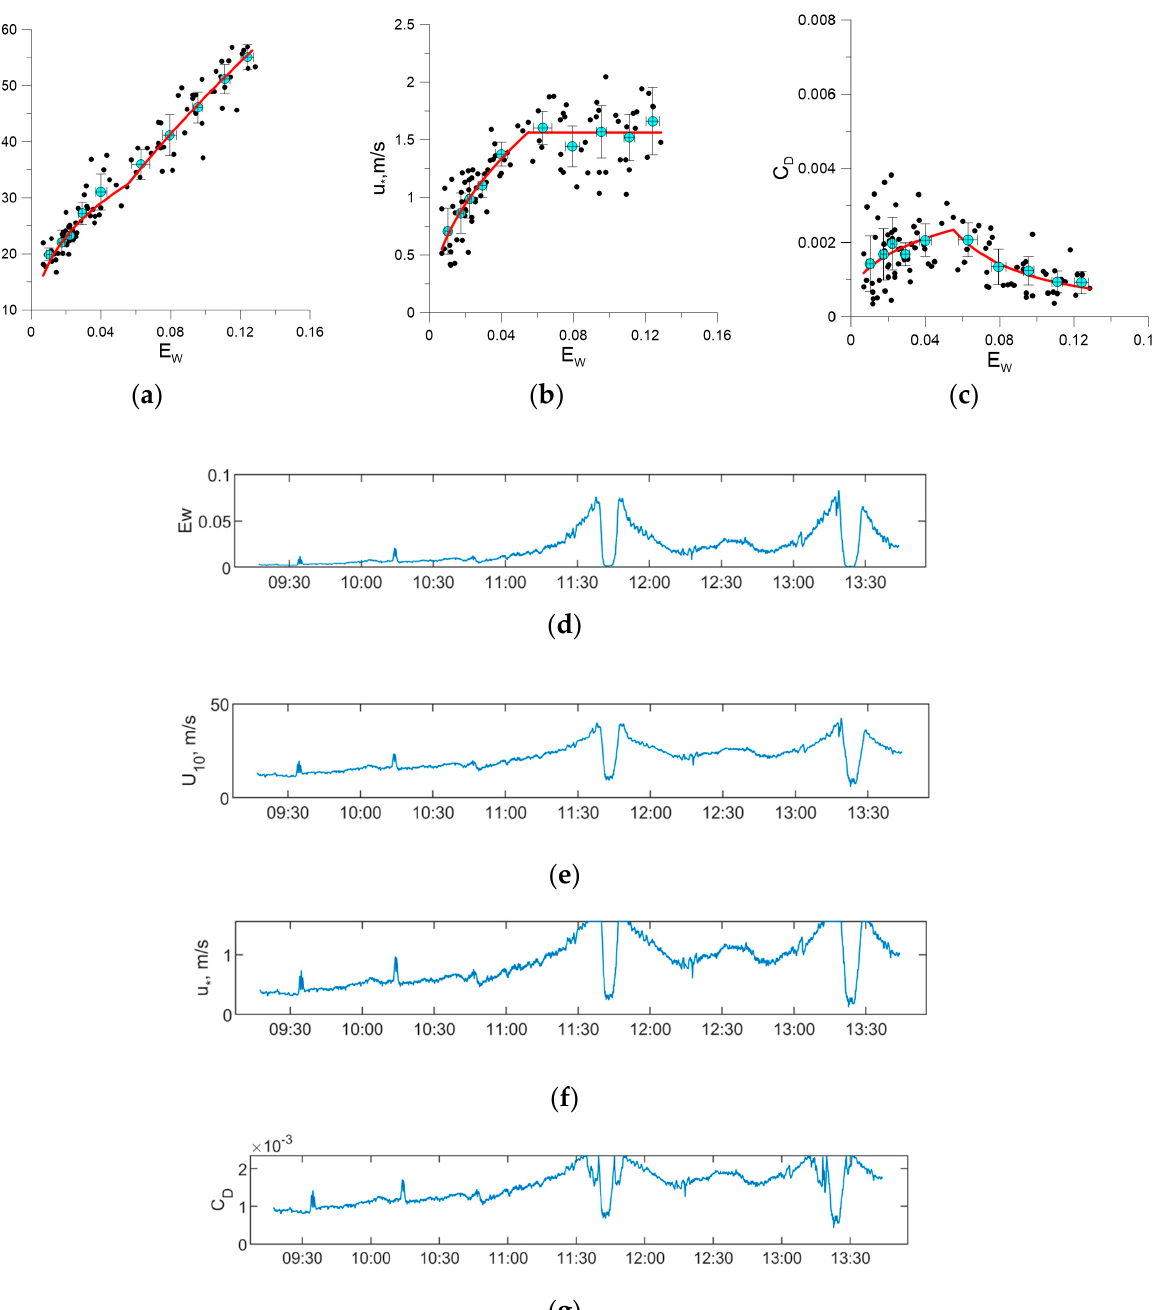
Figure 3. The dependencies of surface wind speed ( a ), the wind friction velocity ( b ), and drag coefficient of the ocean surface ( c ), from GPS-dropsondes data on the ocean surface emissivity. The small symbols are the results of calculations for individual statistical ensembles composed of velocity profiles measured under approximately the same conditions; the large cyan symbols are mean values obtained from averaging inside the E w bins, approximations (6)–(8) of the averaged data illustrated by the large symbols are shown in red color. The solid black line corresponds to the GMF from [40]. Time dependencies of ocean surface emissivity E w ( d ), wind speed U 10 ( e ), friction velocity u ∗ ( f ) and the aerodynamic drag coefficient C D ( g ) for Hurricane Maria from 23 September 2017.